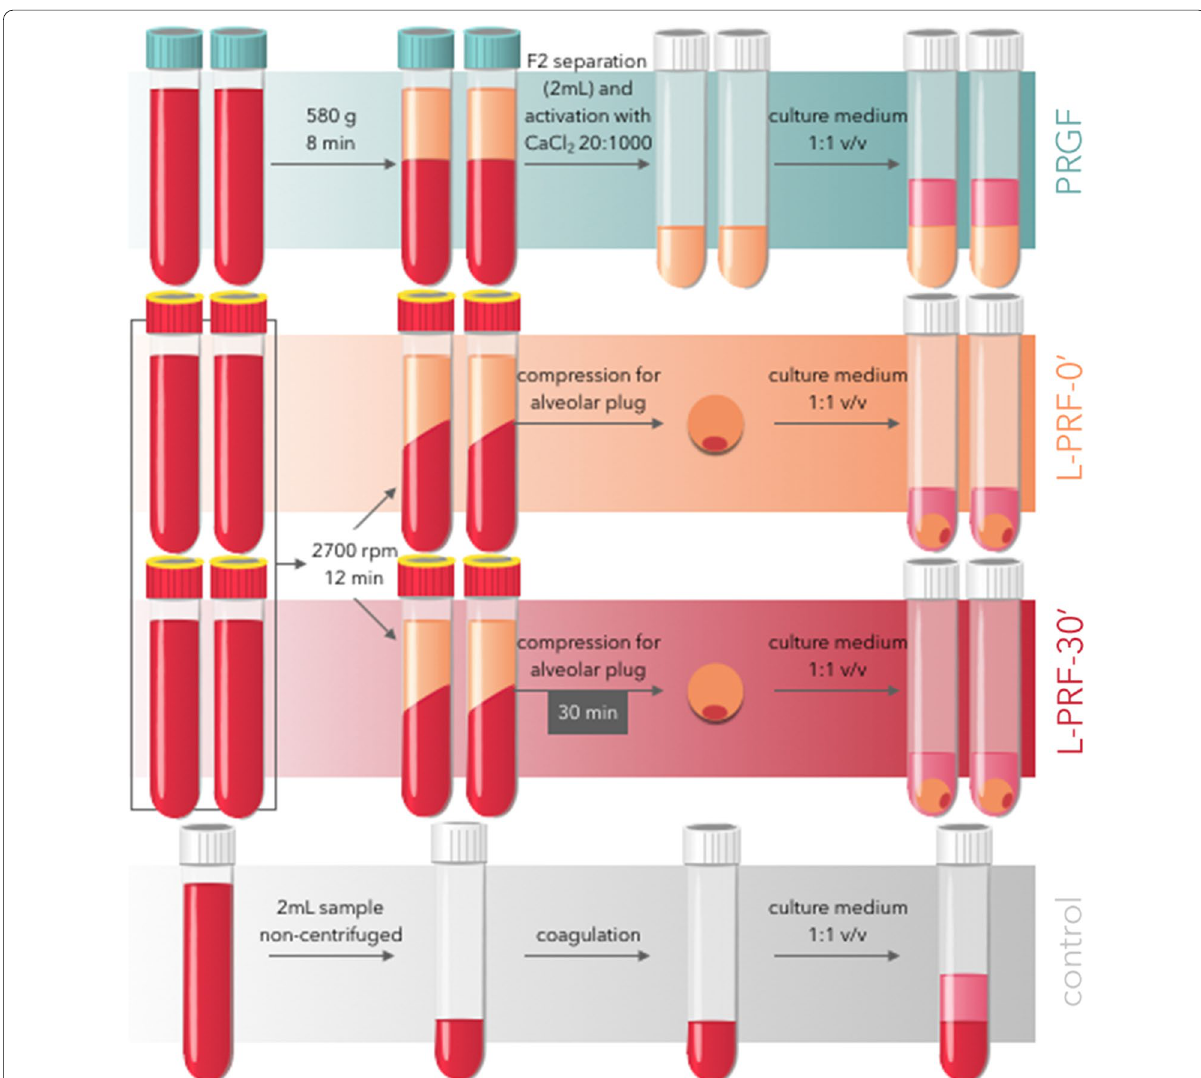
Fig. 1 Scheme of the experimental design of the study. The processing of each platelet concentrate is done according to the protocol and manufacturing